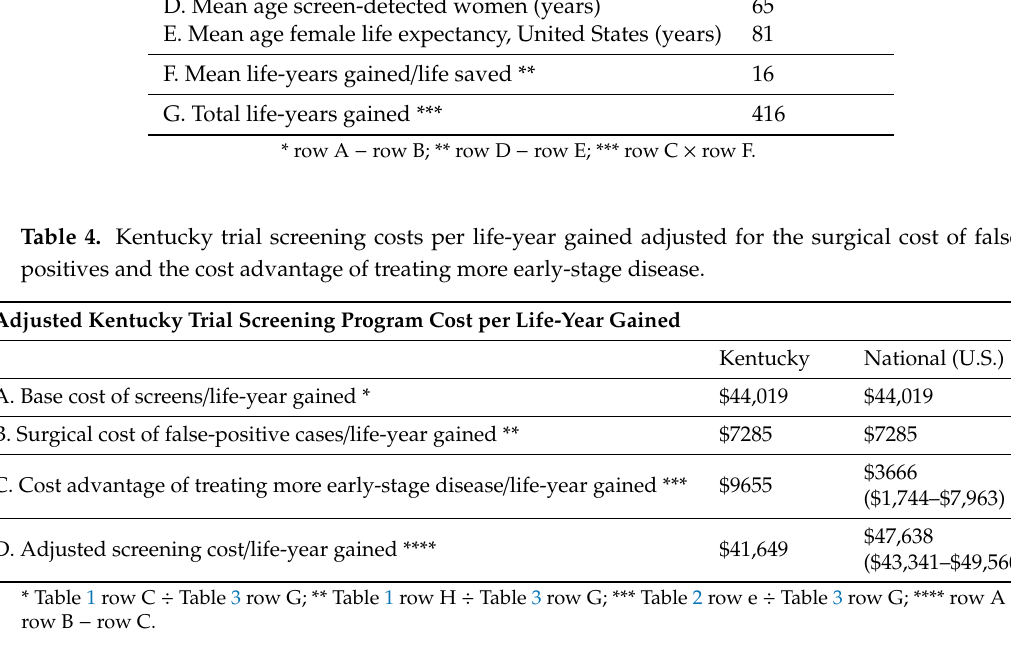
* Table 1 row C ÷ Table 3 row G; ** Table 1 row H ÷ Table 3 row G; *** Table 2 row e ÷ Table 3 row G; **** row A + row B − row